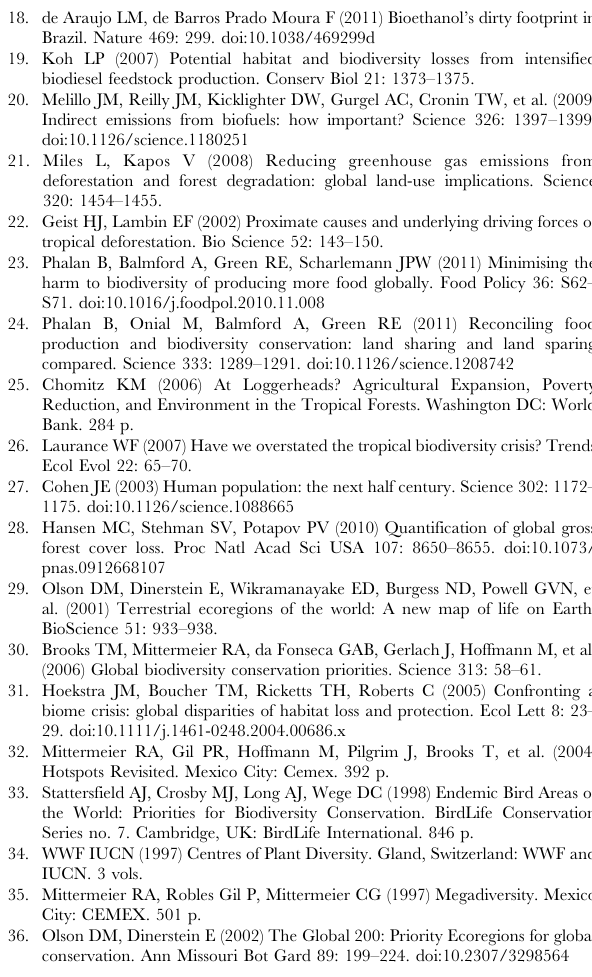
Table S1 Harvested area, annual increment, % rate of expansion and regression statistics for 146 crops in tropical countries, during the period 1999–2008. The 12 most important tropical crops (see text) are in bold.